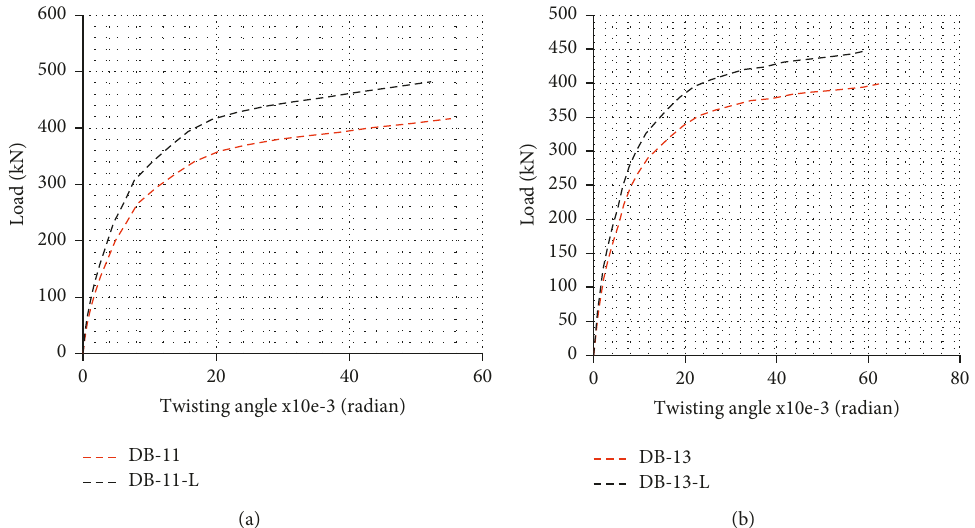
Figure 14: Load-rotation response curves with different longitudinal steel ratios of 0.0011 and 0.123. (a) Beam with L/D and L/R ratios equal to 3 and 1.05, respectively, and (b) beam with L/D and L/R ratios equal to 3 and 1.57, respectively.